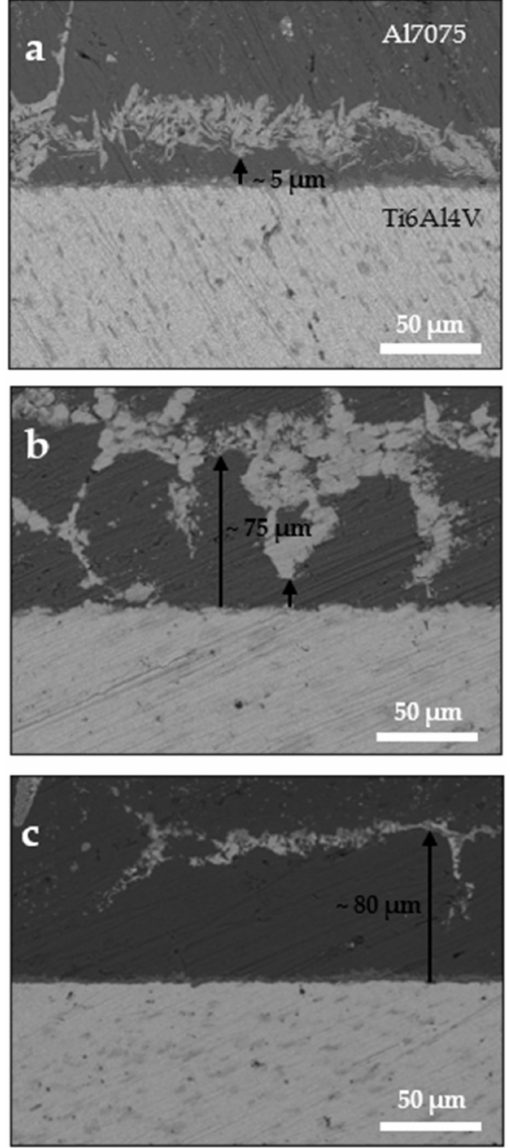
Figure 1. FE-SEM images of the Al7075/Ti-6Al-4V interface with Cu interlayer at 10 MPa and ( a ) 480 ◦ C, ( b ) 500 ◦ C, and ( c ) 520 ◦ C, with a holding time of 10